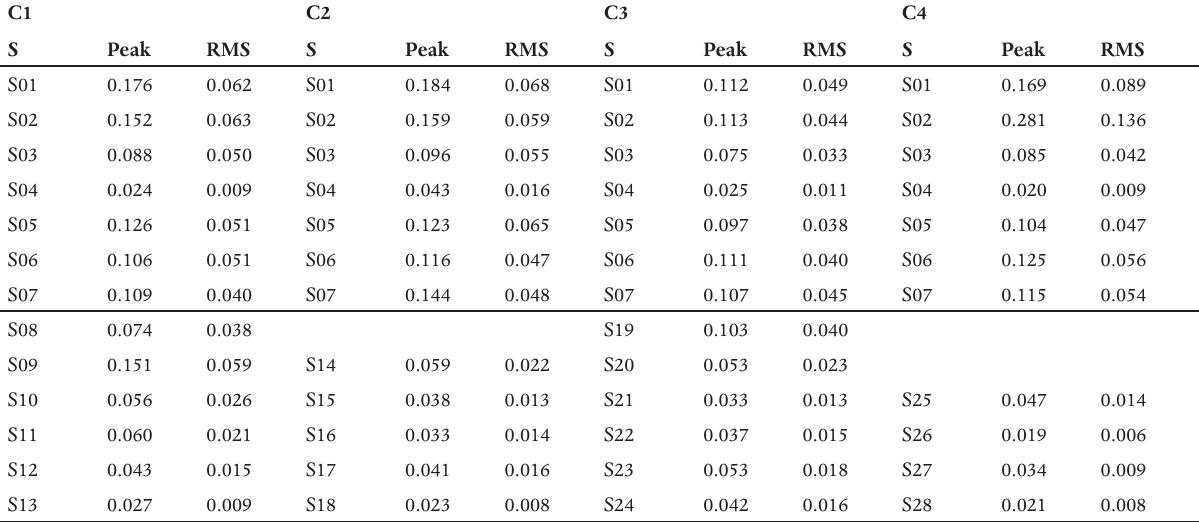
Table 1. Peak values and RMS of the recorded velocity (mm/s).